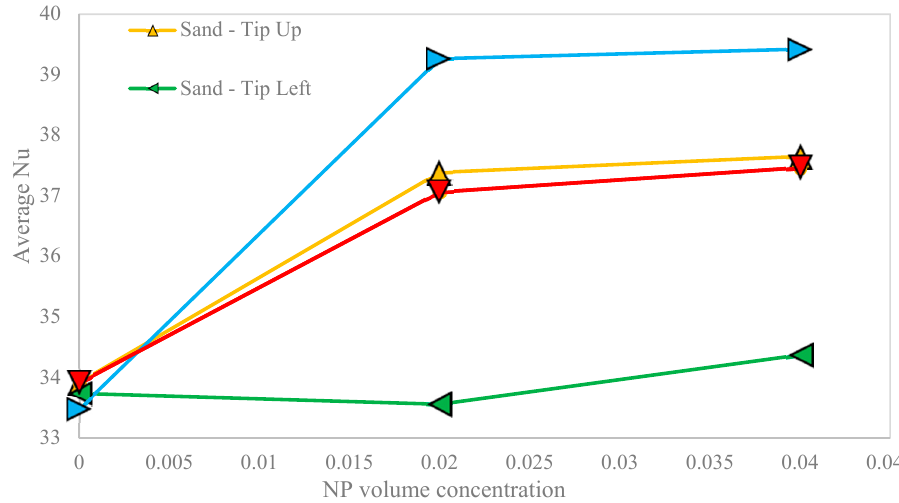
Figure 10. The variation of the average Nu versus the NP volume concentration for the sand-based porous cavity and different orientations of the hot block .